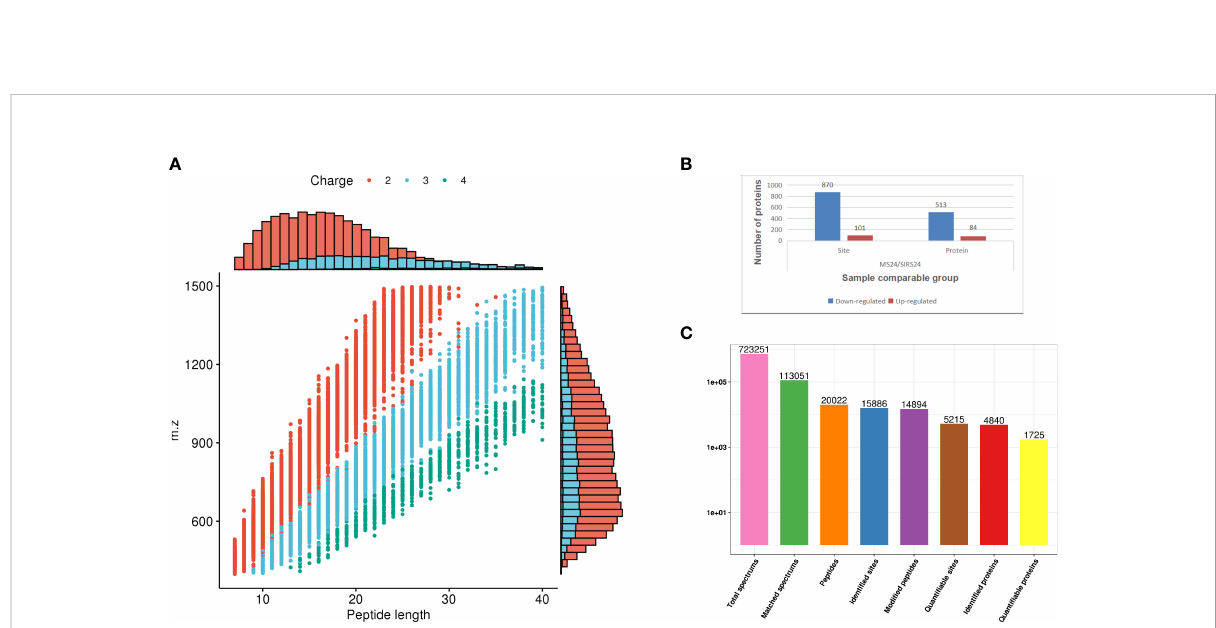
FIGURE 6 Data quality control and quantitative analysis of phosphorylation sites. The distribution of peptide length identi fi ed by mass spectrometry meets the quality control requirements (A) . 4840 phosphorylation sites were identi fi ed by protein phosphorylation analysis, of which 1725 were quanti fi ed (B) . 971 phosphorylation sites were signi fi cantly changed among all the quanti fi ed phosphorylation sites, of which 101 sites were up- regulated and 870 sites were down-regulated (C)